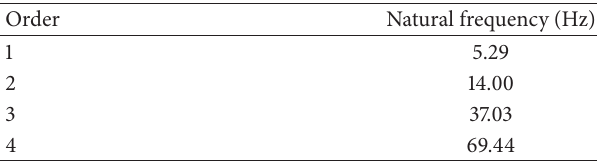
Table 2: Natural frequency calculation results (primary 4 orders).